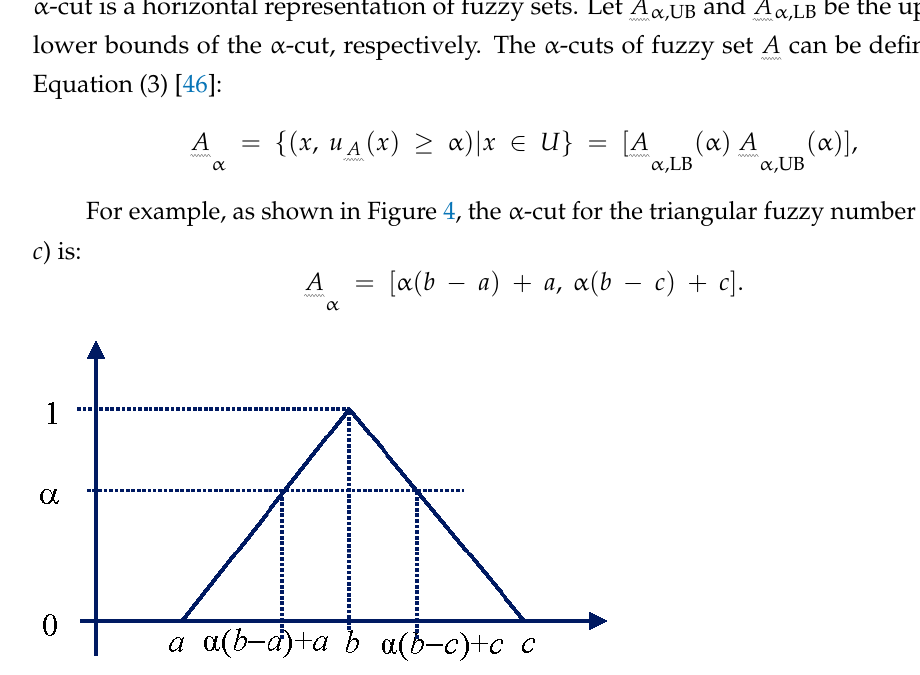
Figure 4. α -cut for a triangular fuzzy number A = ( a , b , c ).